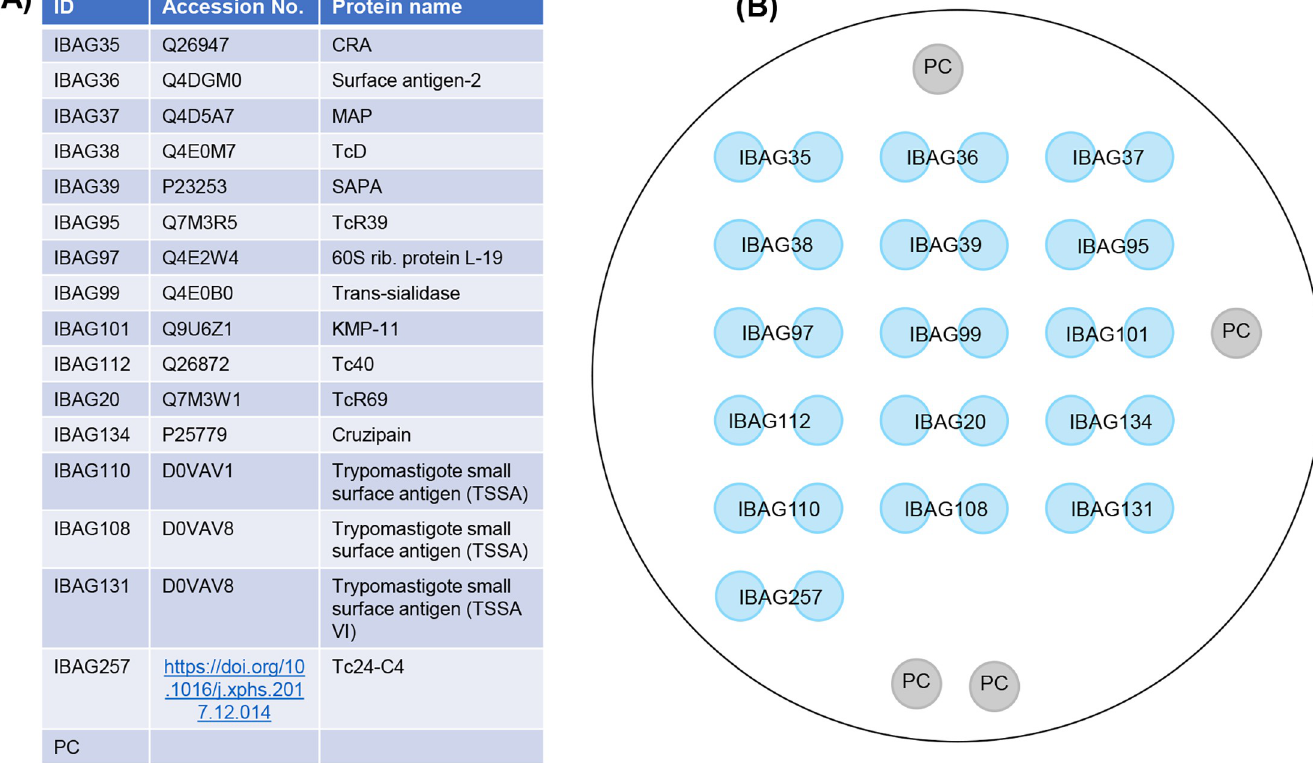
PLOS NeglectedTropical Diseases | https://doi.org/10.1371/journal.pntd.0010827 October 3,